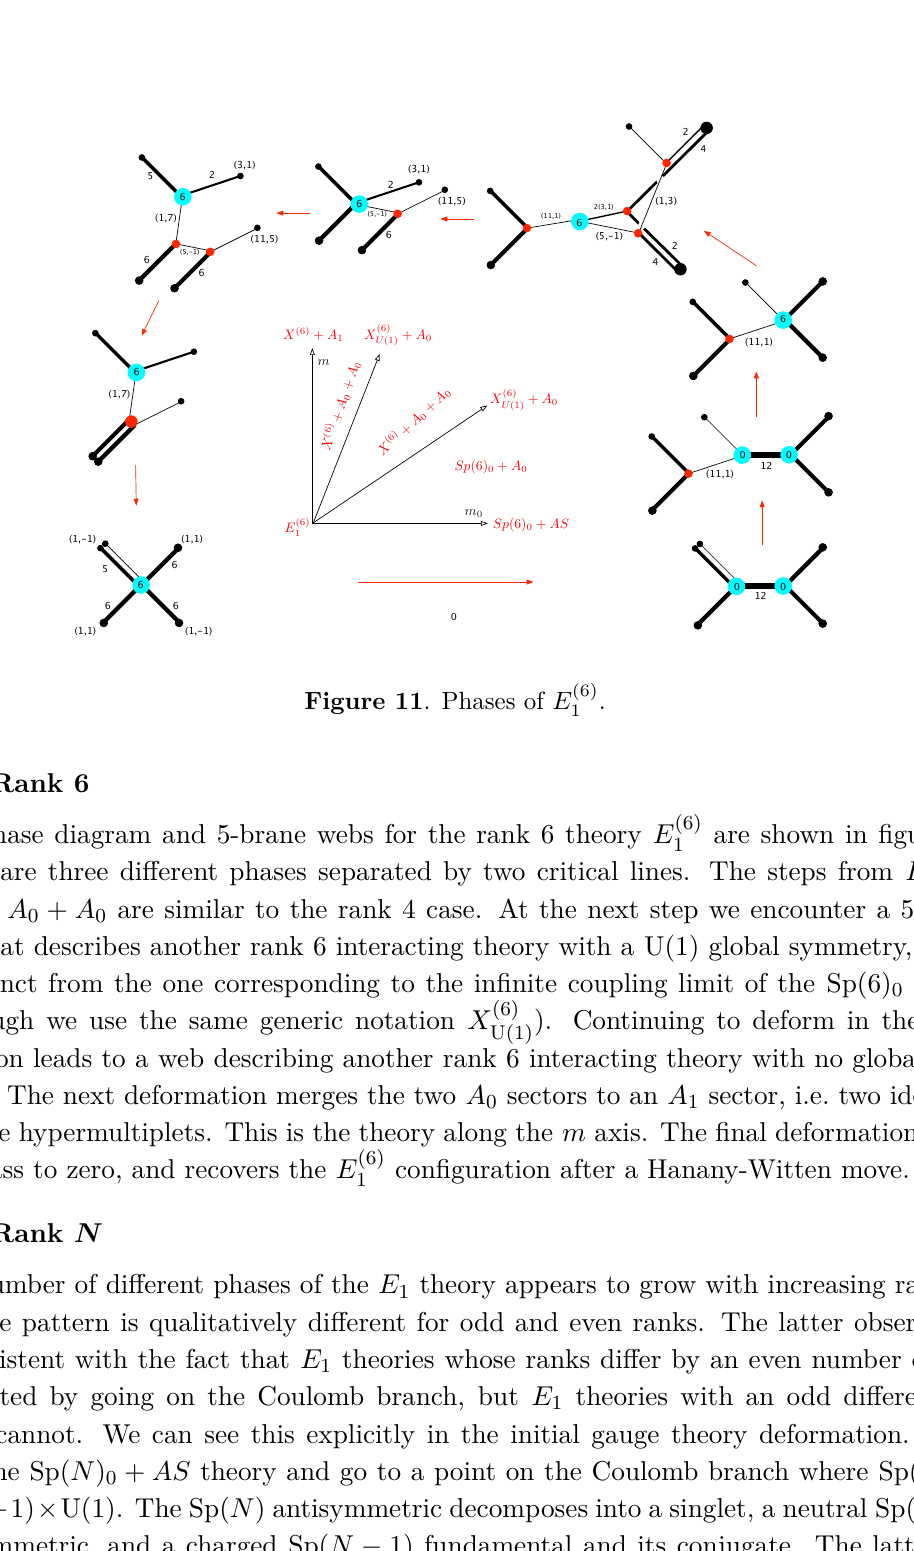
Figure 11 . Phases of E (6)